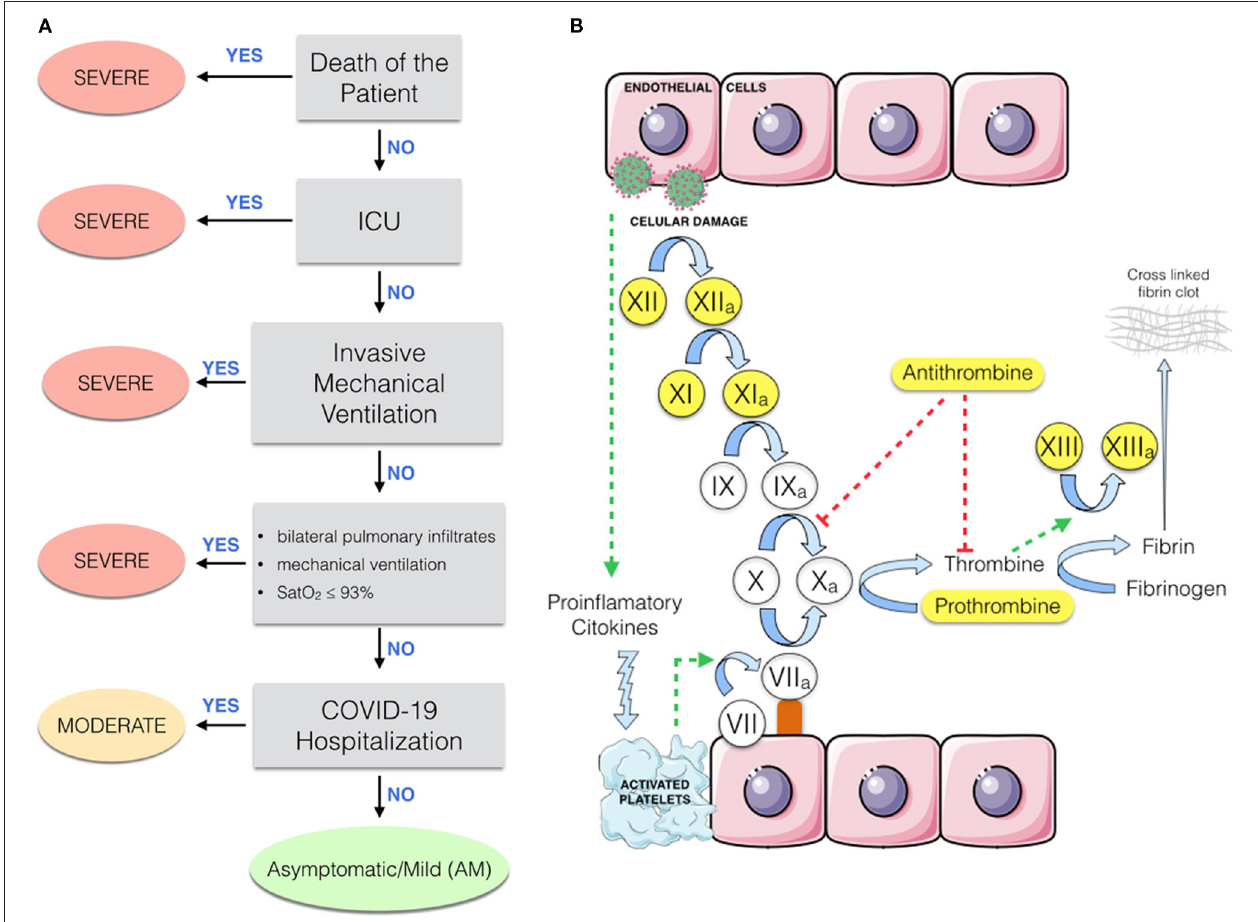
FIGURE 1 | (A) Flowchart describing the classification of patients with respect to COVID-19 severity. ICU, intensive care unit; ARDS, acute respiratory distress syndrome; AM, asymptomatic/mild patients. (B) Partial representation of the coagulation cascade. Proteins analyzed by this study are highlighted in yellow.